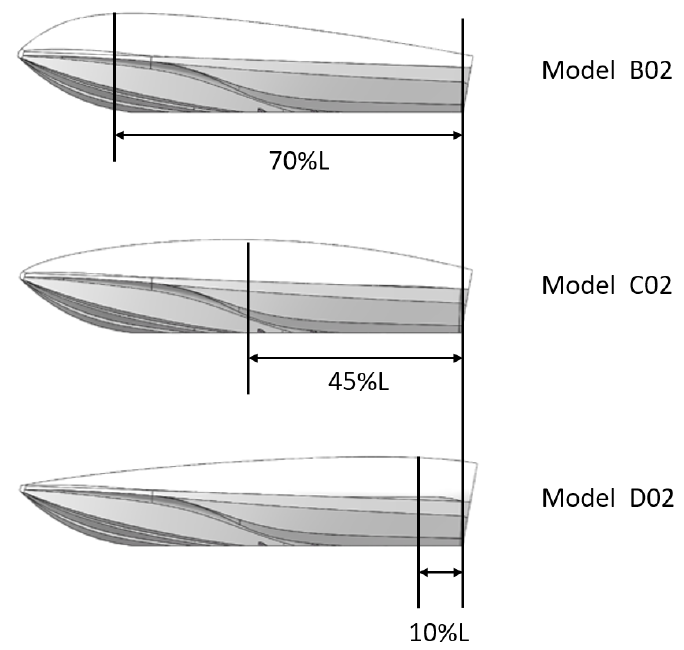
Table 2. Longitudinal position of the highest point of the